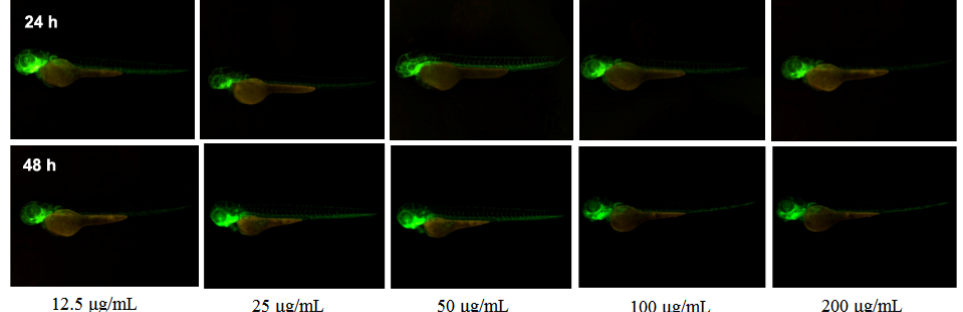
Figure 10. The zebrafish toxicity tests of complex 1 under different concentrations.